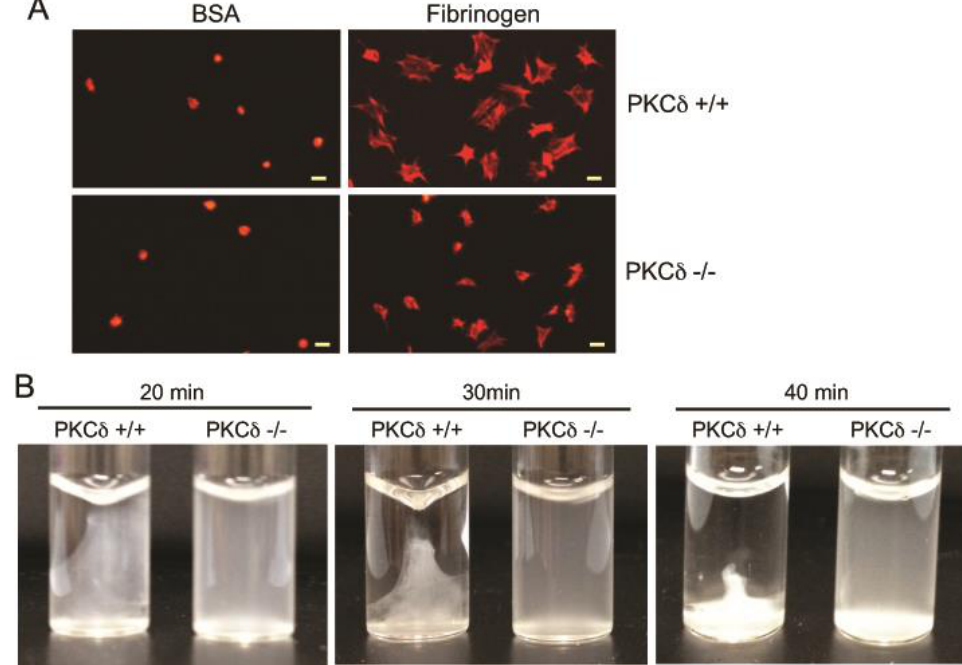
Figure 4. Role of PKCδ in platelet spreading on fibrinogen and clot retraction. ( A ) Washed platelets from PKCδ -/- mice and PKCδ +/+ littermates were plated on either BSA (5 mg/mL) or fibrinogen (100 μg/mL) for 45 min, stained with rhodamine phalloidin, and analyzed by fluorescence microscopy. Scale bar, 5 µm. ( B ) Platelets from PKC δ - / - mice and PKC δ +/+ littermates were mixed with CaCl 2 (1 mM) and fibrinogen (2 mg / mL). Clot retraction was initiated by adding 0.1 U / mL of thrombin and allowed to proceed at 37 ◦ C. Photographs of the clots were taken by a digital camera at 20, 30, and 40 min. The data shown are representative of three independent